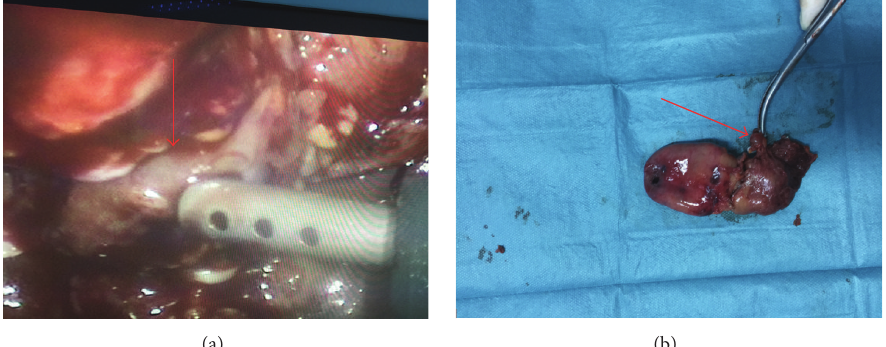
Figure 2: Pre- (a) and postoperative images (b). Arrows demonstrated cystic artery